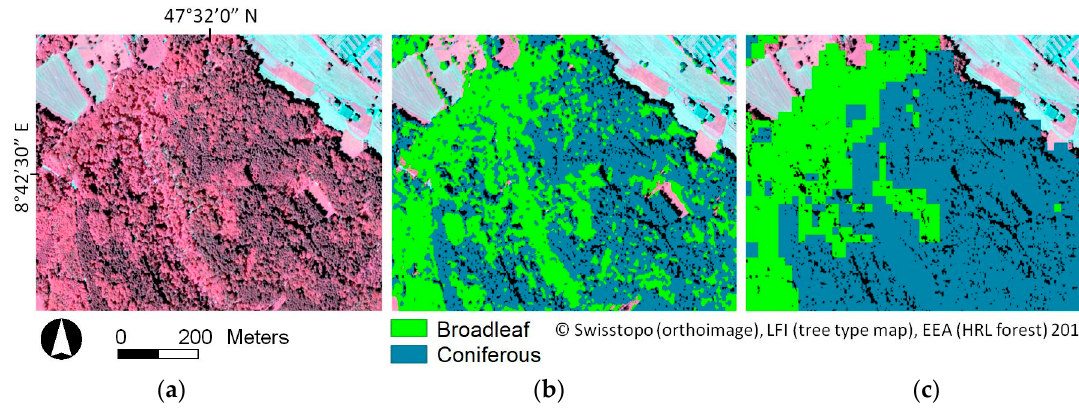
Figure 8. ( a – c ) Differences in tree types and level of detail between the tree type map ( b ) and the High Resolution Layers ( c ). The CIR orthoimage ( a ) is given as a reference, where coniferous trees appear darker red than broadleaved trees.